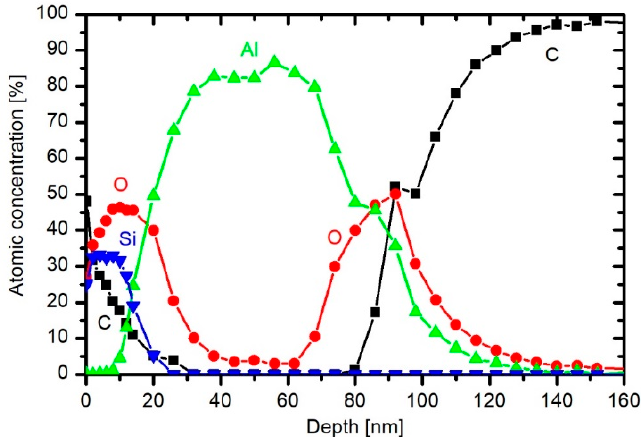
Figure 6. The XPS depth profile of the protective coating on a polymer substrate.